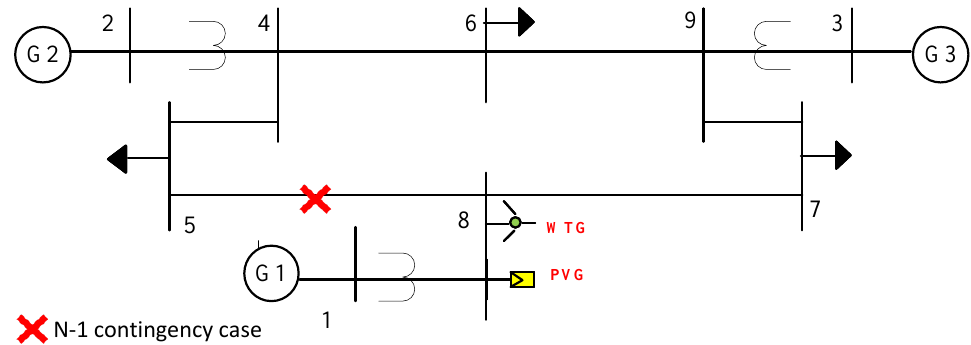
Figure 9. IEEE 9 Bus